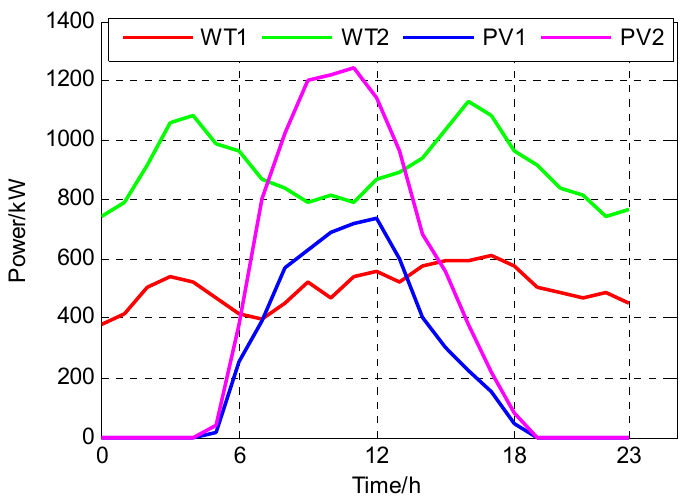
Figure 9. The output complementary characteristic curve of DG.